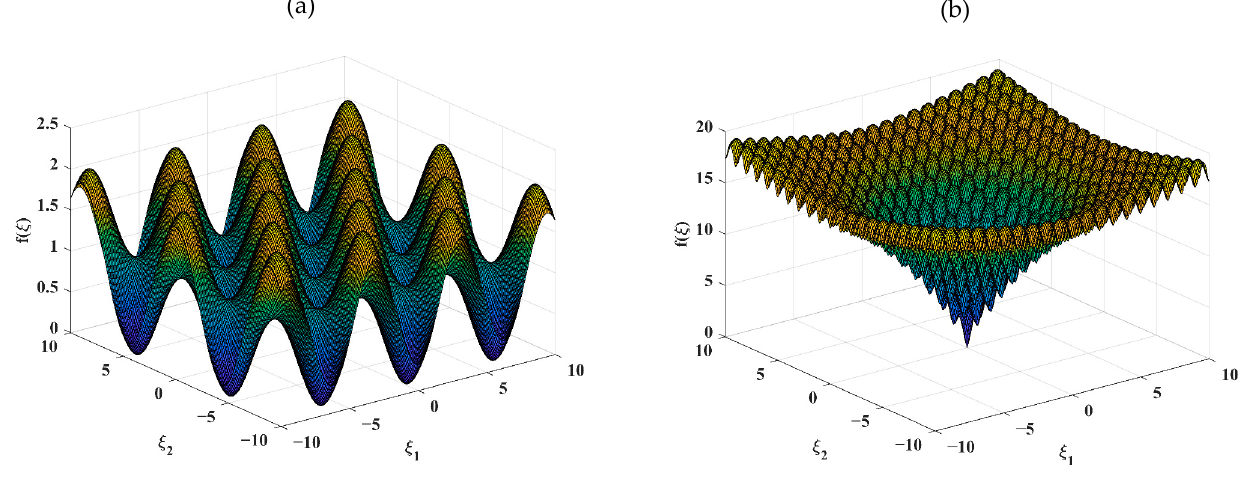
Figure 1. Descending trend of different inertia weights when α ( 0 ) = 0.234. Two test functions (i.e., Griewank and Ackley function) with the same independent